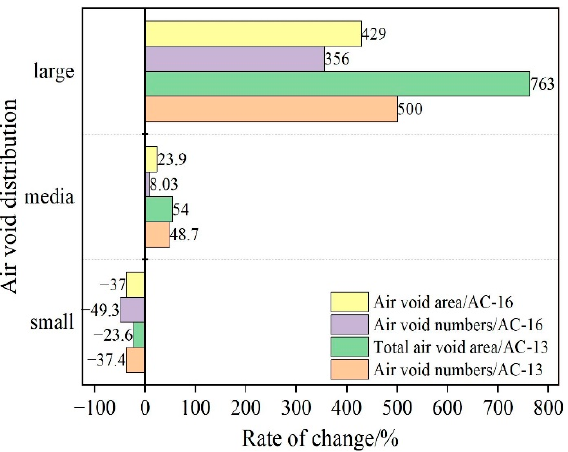
Figure 19. Changes in area and quantity of air voids with different sizes.